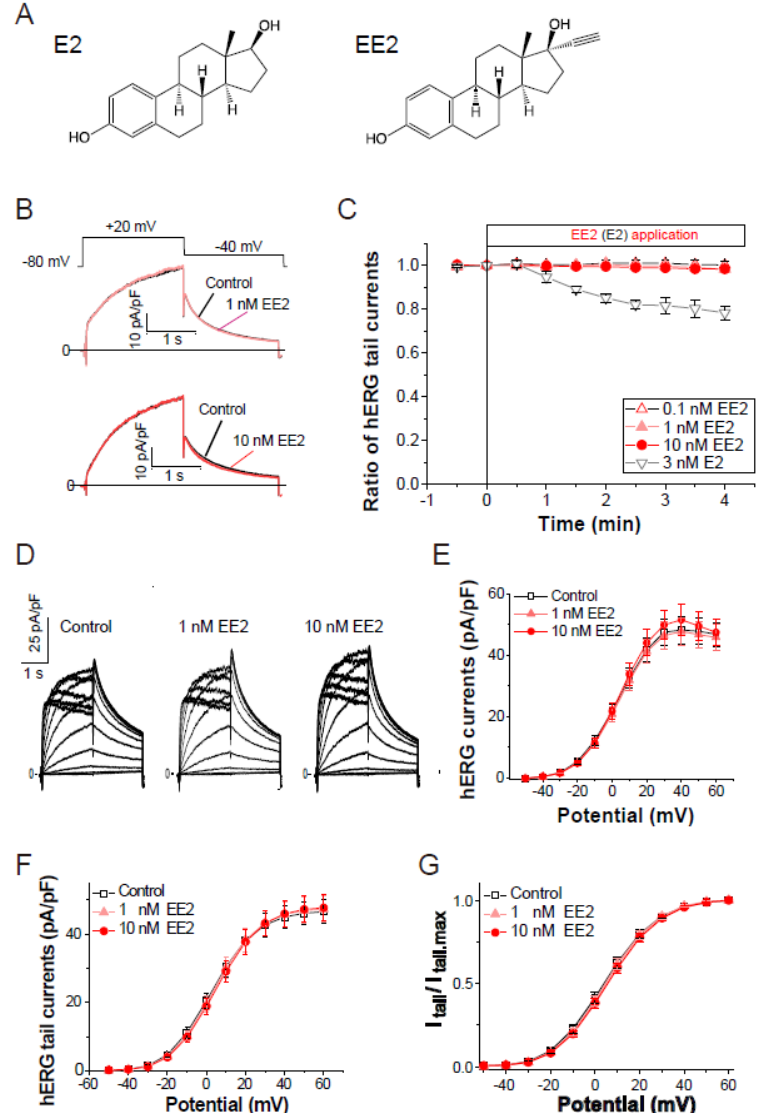
Figure 1. Effects of the external application of ethinylestradiol, EE2, on hERG channel currents. Membrane currents were recorded from HEK293 cells stably expressing hERG. The hERG channels were sequentially activated at 0.1 Hz by 2-s test pulses from a holding potential (V h ) at − 80 mV. ( A ), Chemical structures of E2 (left) and EE2 (right). ( B ), Representative traces before and after the application of EE2 (upper; 1 nM, lower; 10 nM) for 4 min. ( C ), Time courses of the effects of EE2 at 0.1 nM (open triangles, n = 5), 1 nM (closed triangles, n = 8), and 10 nM ( n = 7), and E2 at 3 nM (closed triangles, n = 5). After stabilizing the tail amplitudes for 1 min, currents were recorded in the presence of each concentration of EE2 in the bath solution. Plots (means ± S.E.M.) are shown as ratios of the peak tail amplitudes just before the application of estrogens (control at time zero). ( D – G ), No effect on current-voltage relationships of the hERG channel elicited by a series of 2-s test pulses from − 50 to 60 mV (10-mV increments, 0.1 Hz). ( D ), Representative superimposed traces at step pulses (2-s test pulses, − 40 mV return, V h = − 80 mV) from a single cell before (left) and after a 5-min cumulative application of EE2 from 1 nM (middle) to 10 nM (right). ( E ), Current–voltage relationship at the end of test pulses. ( F ), Current–voltage relationship of tail peak currents recorded at − 40 mV. ( G ), Normalized peaks of tail currents were plotted as a function of the hERG activation (Boltzmann fitting). Eighteen cells were used. Data are summarized in Table